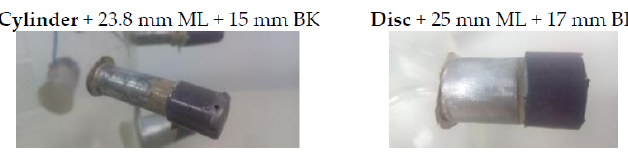
Figure 18. Glued ceramics with matching layer and backing.